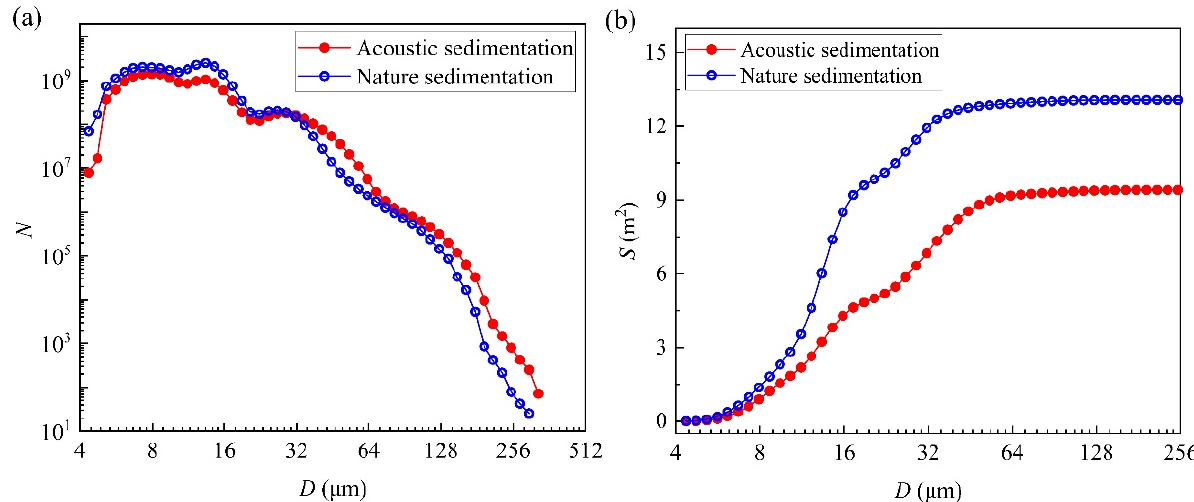
Figure 7. ( a ) Curve of the micro-droplet group numbers and ( b ) their cumulative surface area.